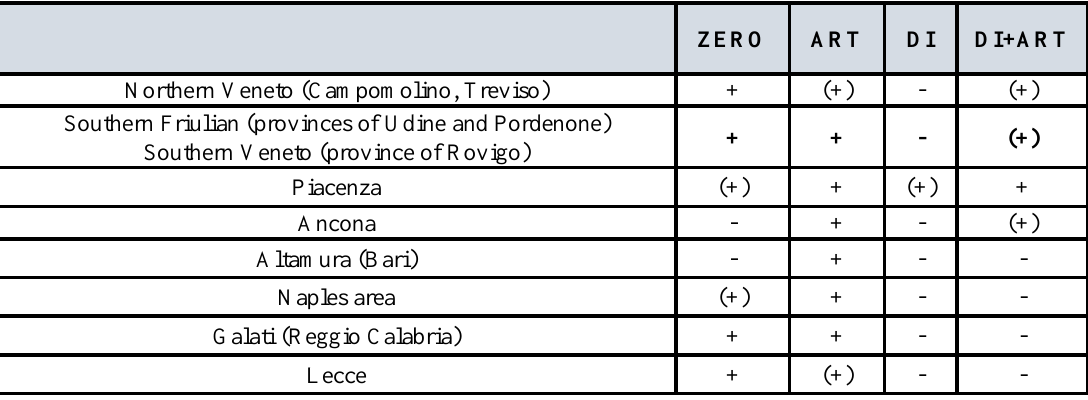
Table 2. Indefinites in object position in modern Italian